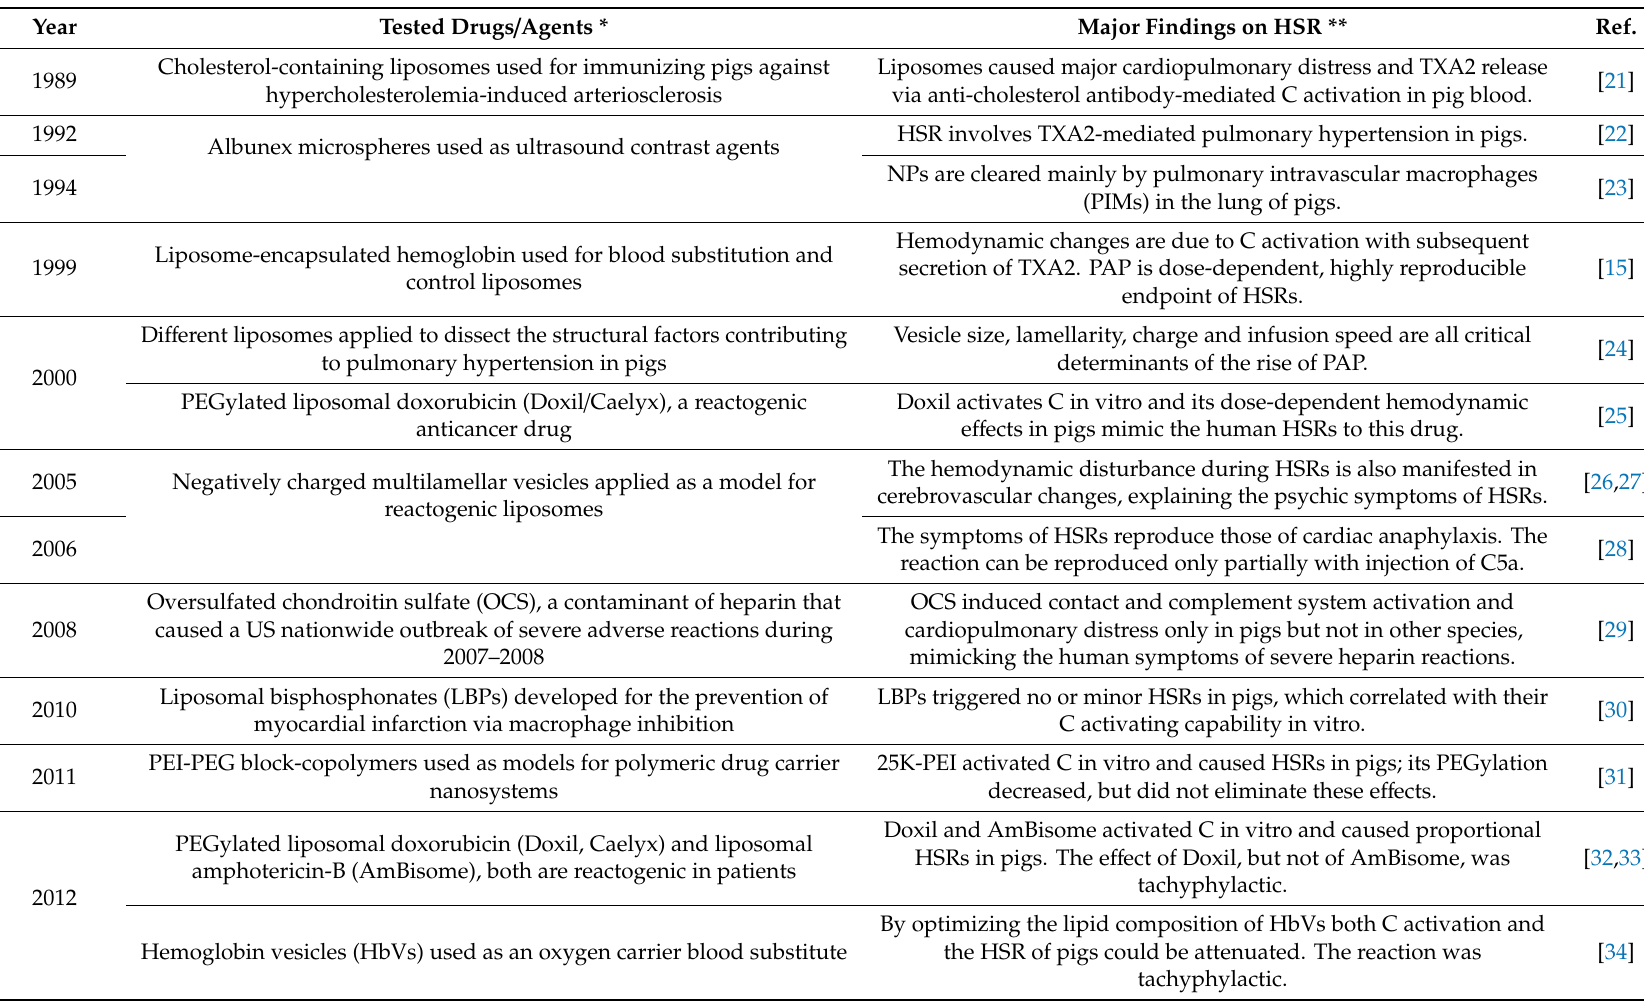
Table 1. Chronological list of pig studies which included the analysis of hemodynamic changes and other endpoints of hypersensitivity reactions to i.v. drugs. Year Tested Drugs / Agents * Major Findings on HSR ** Ref.